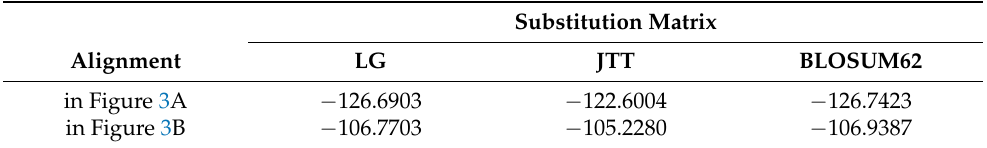
Table 3. Tree log-likelihood values for the two multiple sequence alignments in Figure 3, obtained with PhyML and three different substitution